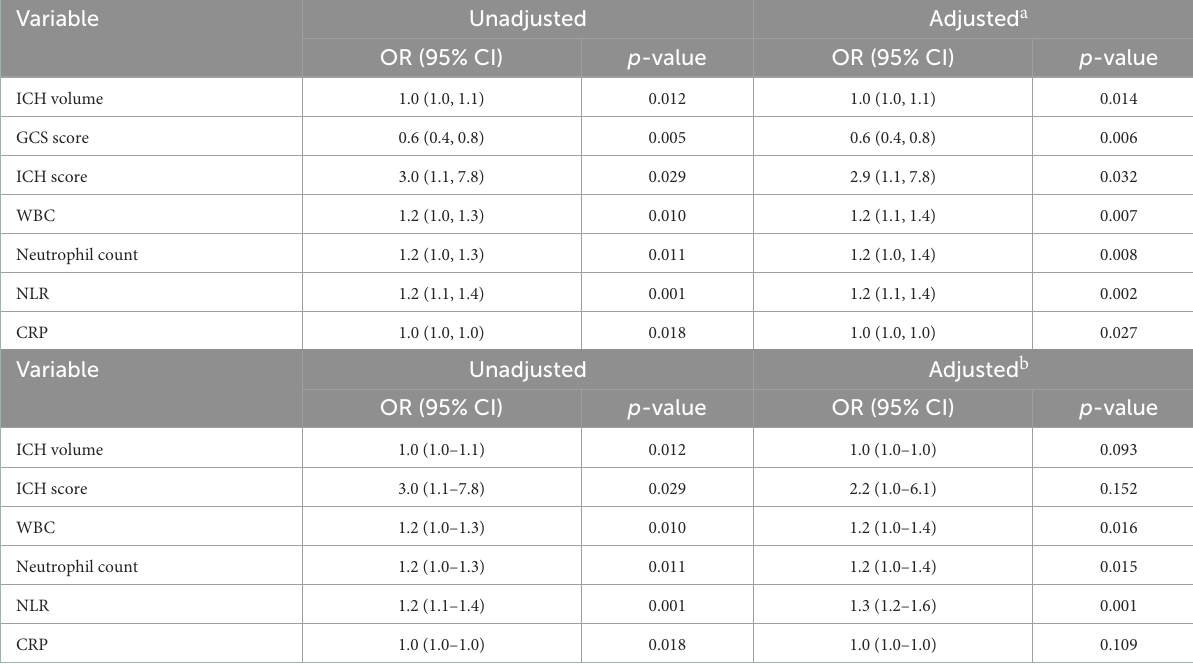
TABLE 3 Adjusted risk factors for 30-day mortality in ICH patients.